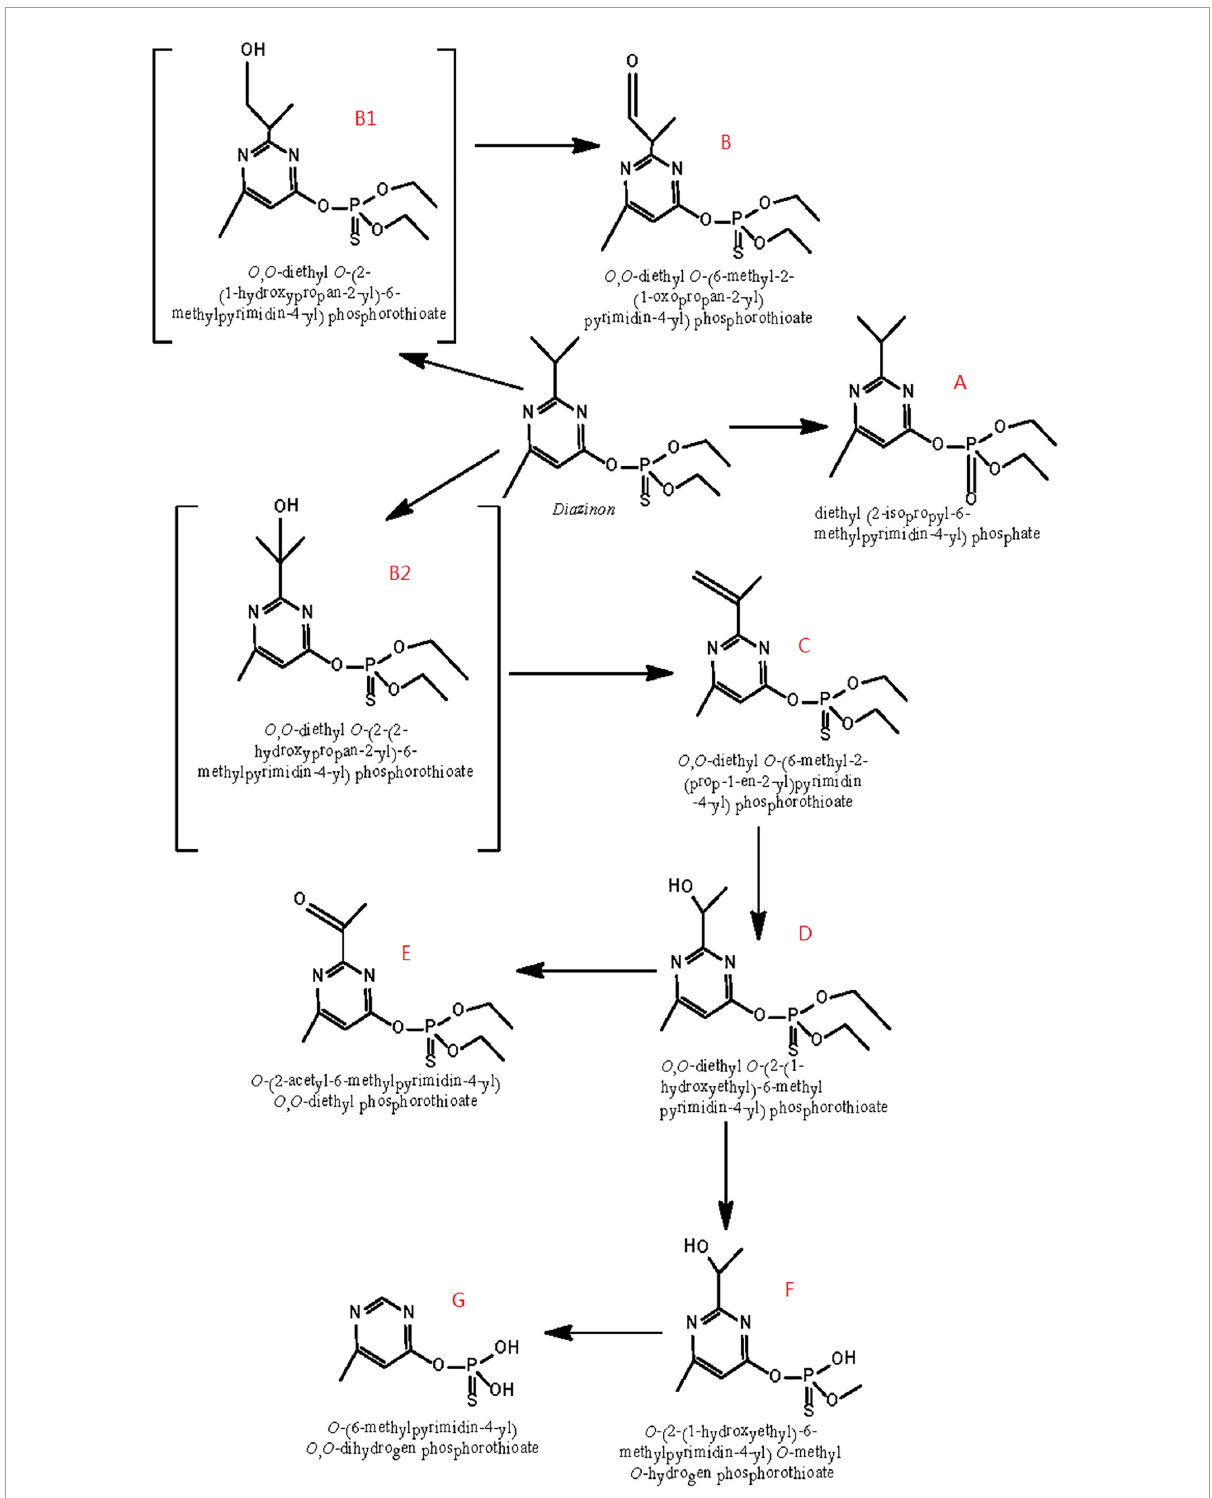
FIGURE6 Scheme of the proposed degradation pathway of diazinon in liquid cultures: (A) diazoxon; (B) diazinon aldehyde; (C) isopropenyl derivative of diazinon; (D) hydroxyethyl derivative of diazinon; (E) diazinon methyl ketone; (F) O -[2-(1-hydroxye thyl)-6-methyl pyrimidin-4-yl] O -methyl O -hydrogen phosphorothioate; (G) O -(6-methyl pyrimidin-4-yl) O , O -dihydrogen phosphorothioate; B1: 2-hydroxydiazinon { O , O -diethyl- O -[2-(1-hydroxypropan-2-yl)-6-methylpyrimidin-4-yl] phosphorothiotae}; B2: hydroxy diazinon { O , O -diethyl O -[2-(2-hydroxypropan-2-yl)-6-methylpyrimidin-4-yl]